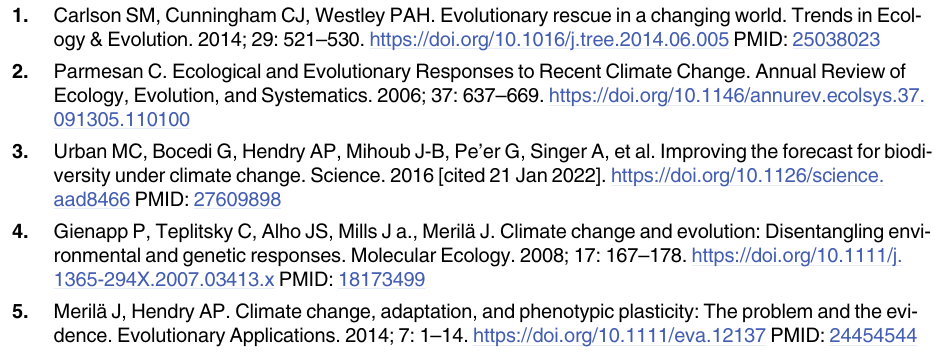
S2 File. Orthologous clusters associated with Fig 4B. Orthologous clusters and singletons for the gene orthology analysis between temperature-responsive D . pulicaria genes, kairomone- responsive D . pulicaria genes, temperature-responsive genes in D . pulex , and kairomone- responsive genes in D . pulex . D . pulex genes were collected from the Daphnia Stressor Data- base. Data is in Excel